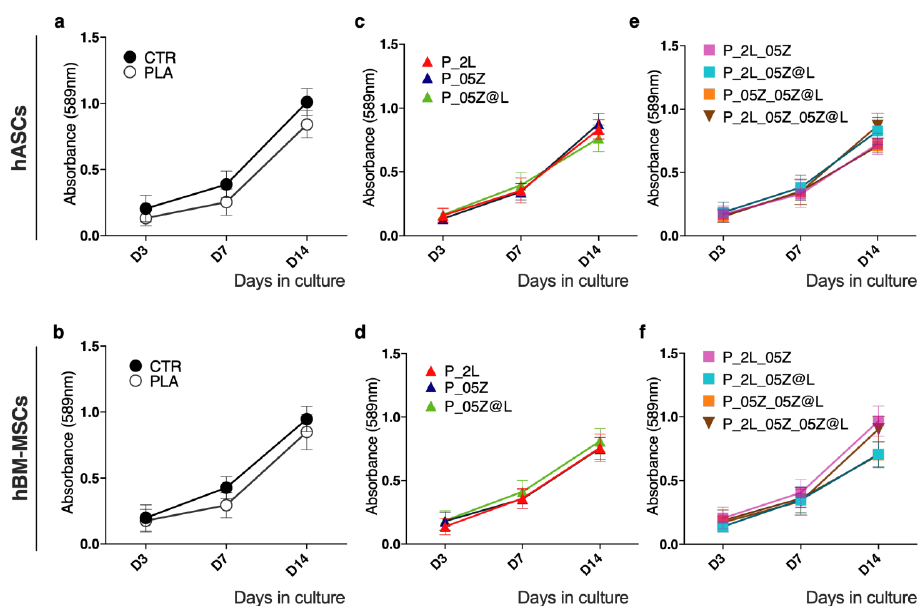
Figure 8. Mesenchymal stem cell viability and proliferation on PLA films. MTT assay of ( a , c , e ) human adult adipose stem cells (hASCs) and ( b , d , f ) human bone marrow-mesenchymal stem cells (hBM-MSCs) on PLA, PLA-binary, -ternary, -quaternary films and canonical culture conditions (CTR) at 3, 7 and 14 days. Data are representative of three independent experiments which yielded similar results.